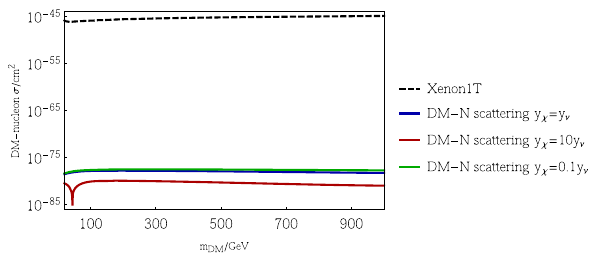
Fig. 7 Theexpecteddirectdetectionsignalsforthecouplingstructures investigated within Sect. 5 are compared to the current bounds from XENON1T [33] (dashed black curve). The dip in the red curve is due to a cancellation appearing in the loop